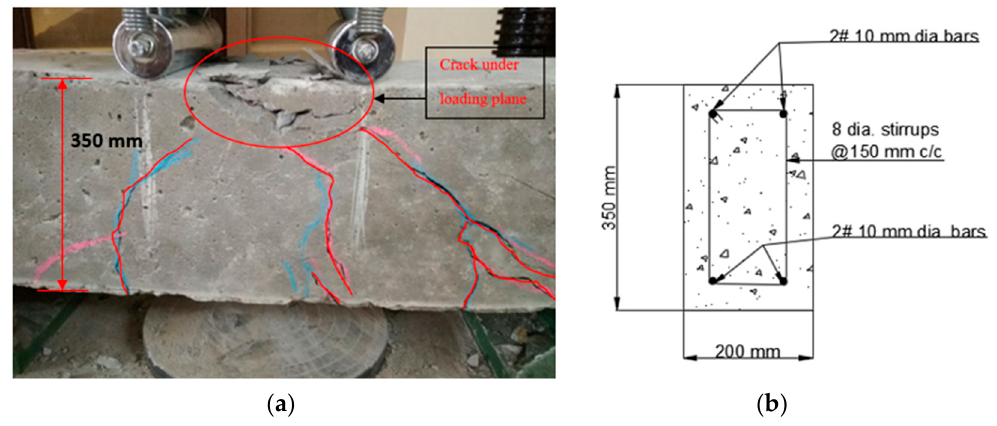
Figure 7. ( a , b ) Failure of controlled beam.